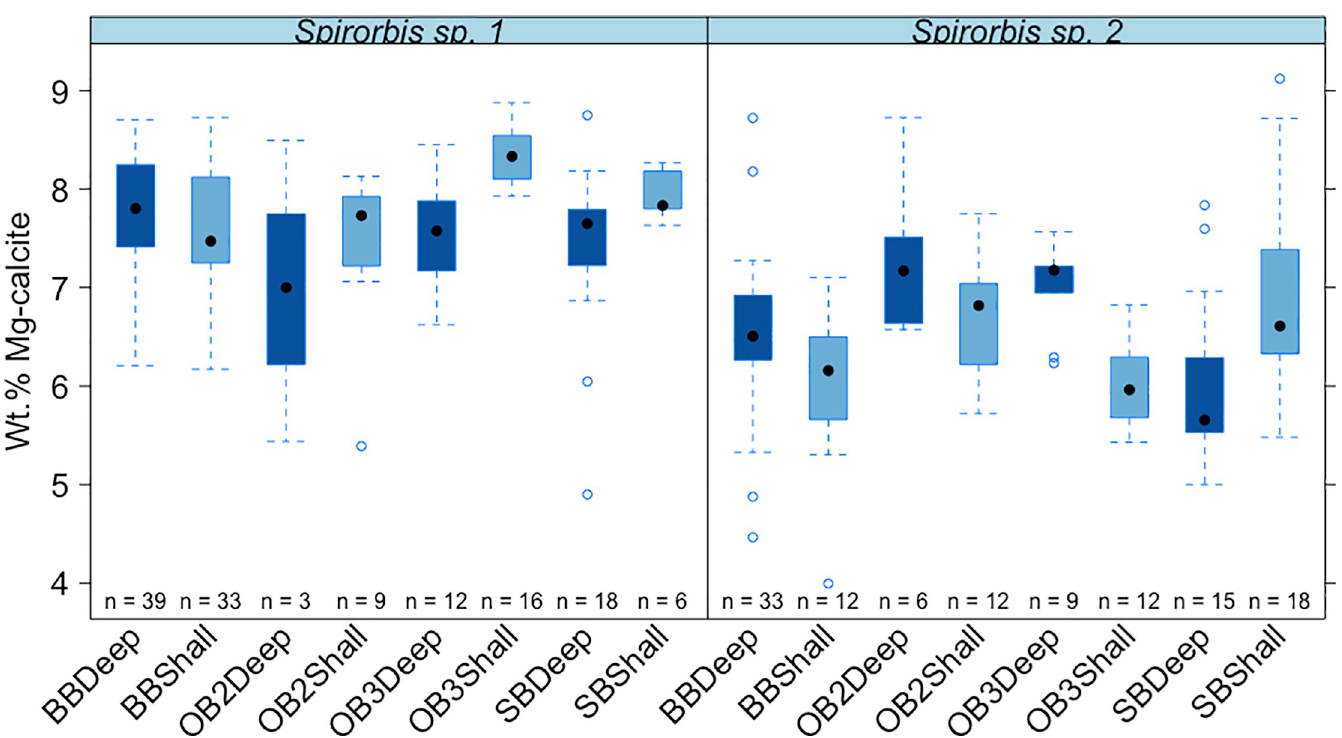
Fig 7. Mean values ( ± standard error) of wt% MgCO 3 in calcite in the two Antarctic spirorbid species among different sites and depths. Boxes depict standard deviation around mean (mid-line); tail indicates range. Colours indicate deep and shallow waters. � Brown Bay = BB , OB2 = O'Brien Bay -2 , OB3 = O’Brien Bay-3 , SB = Shannon Bay . Deep = Deep , shallow = Shall .